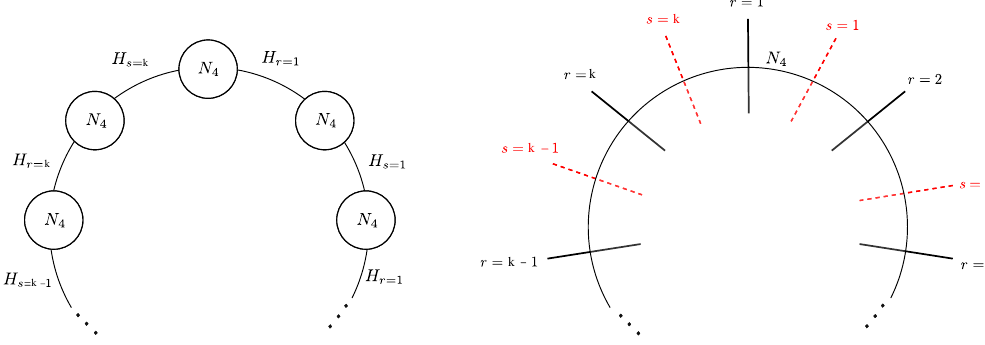
Figure 9 . Circular quiver associated to the KW theory modded by Z k , and corresponding brane set-up. There are N 4 D4-branes stretched between p = k NS5-branes, labeled by r = 1 ; : : : ; k (as for the corresponding hypermultiplets) and q = k NS5’-branes labeled by s = 1 ; : : : ; k . NS5 and NS5’-branes are represented by transversal black and red dashed lines,